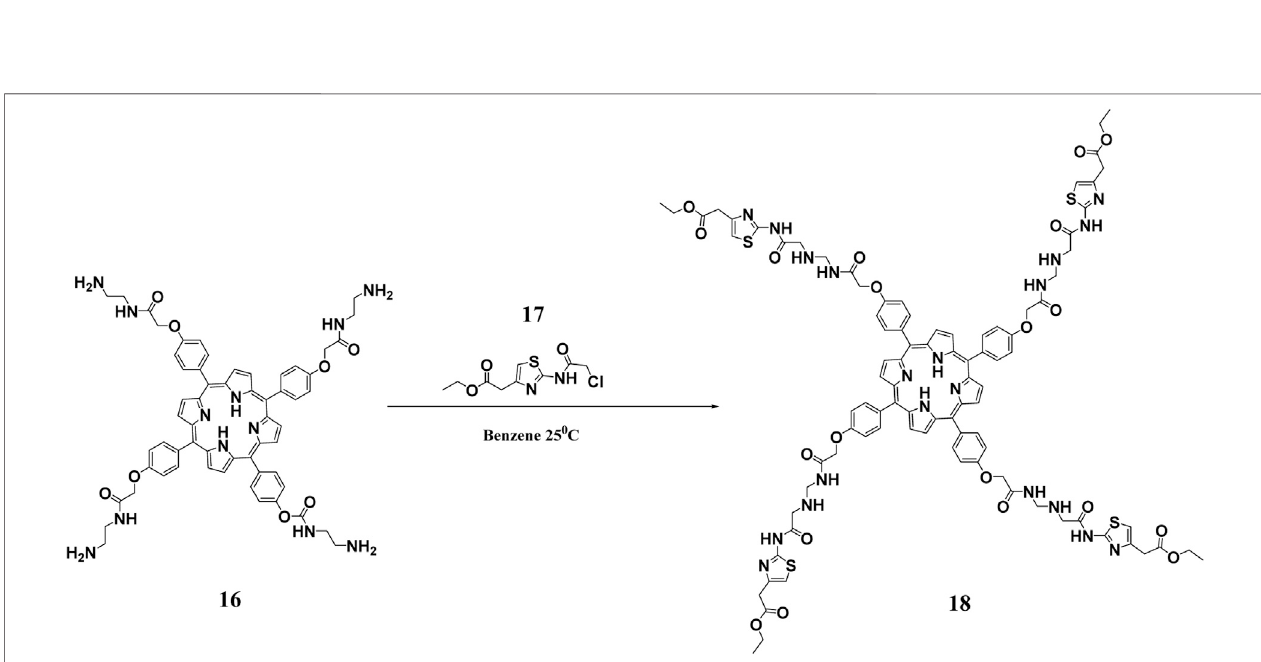
Frontiers in Chemistry |